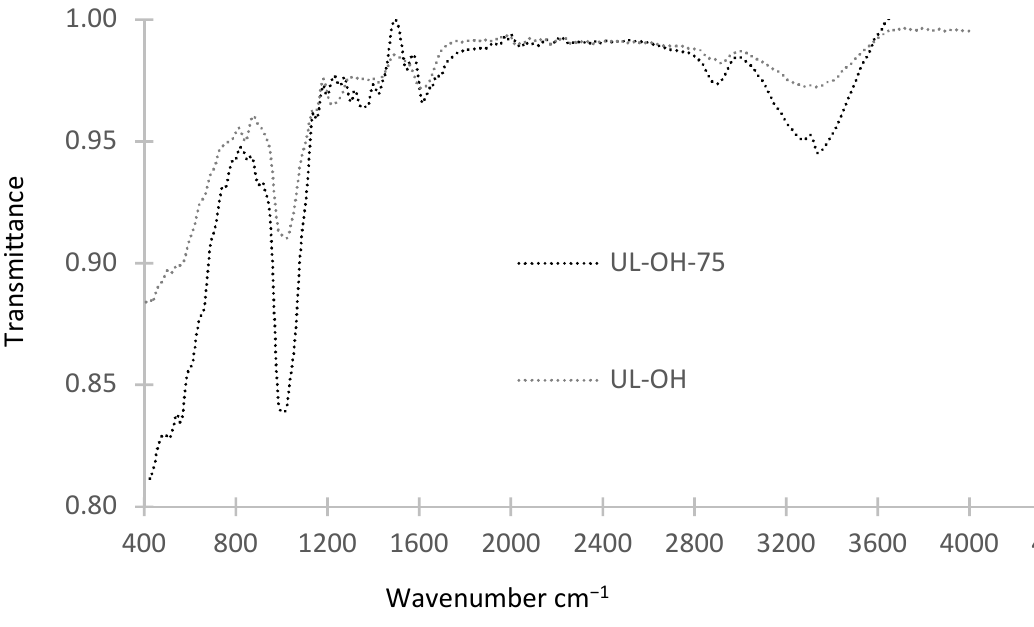
Figure 3. IR Spectra of the untreated (UL-NA), UL-WIS, and treated (UL-H, UL-OH, UL-T) dry U. lactuca after 75 min of contact with methylene blue (MB).